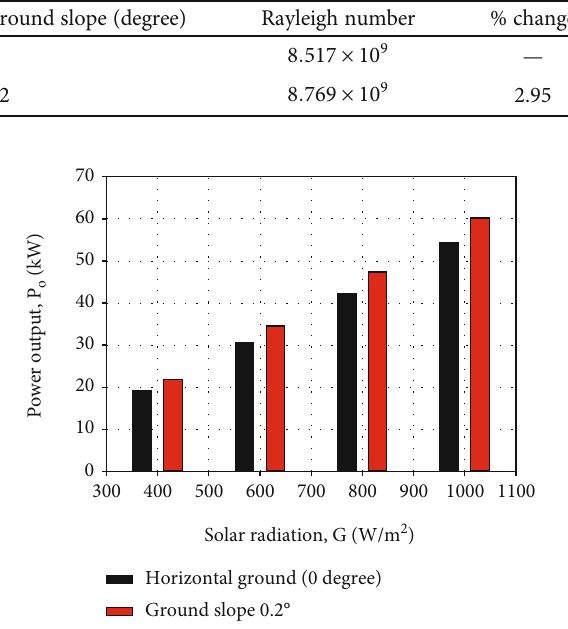
Figure 10: Comparison of power outputs for horizontal and 0.2 ° sloping ground under di ff erent solar radiation